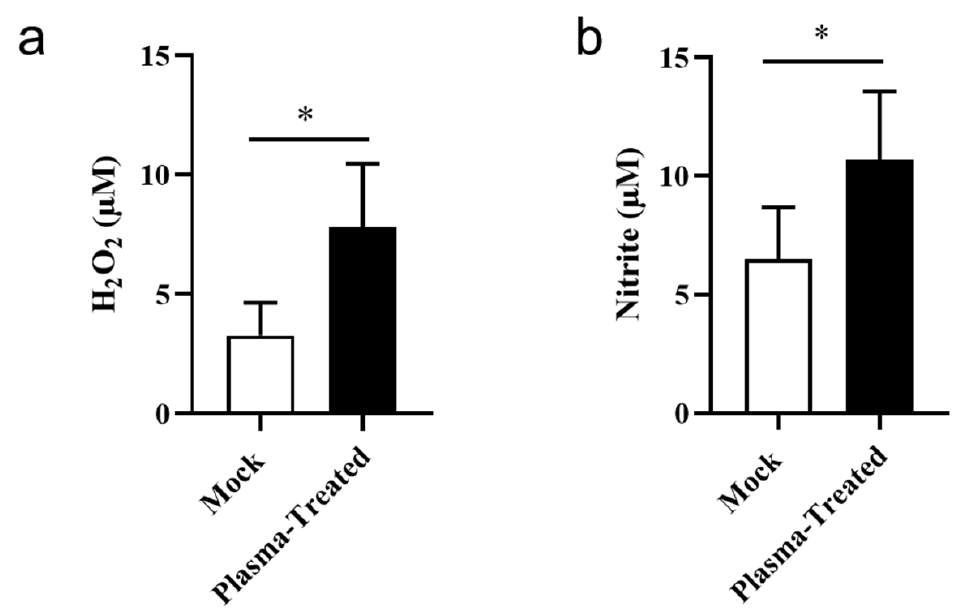
Figure 6. CAP treatment for 3 min daily for 14 days slightly increases ROS/RNS levels in the tumor microenvironment. Concentrations of ( a ) H 2 O 2 and ( b ) nitrite in the tumor interstitial fluids (TIFs) in the mock and PT groups, n = 5. The data are from five biologically independent animals (means ± SD) and the statistical analysis is carried out using two-sided unpaired t -tests (* p < 0.05). 3.7. High CAP Treatment-Generated ROS/RNS Dose In Vitro Induces Apoptosis in Both T Cells and Tumor